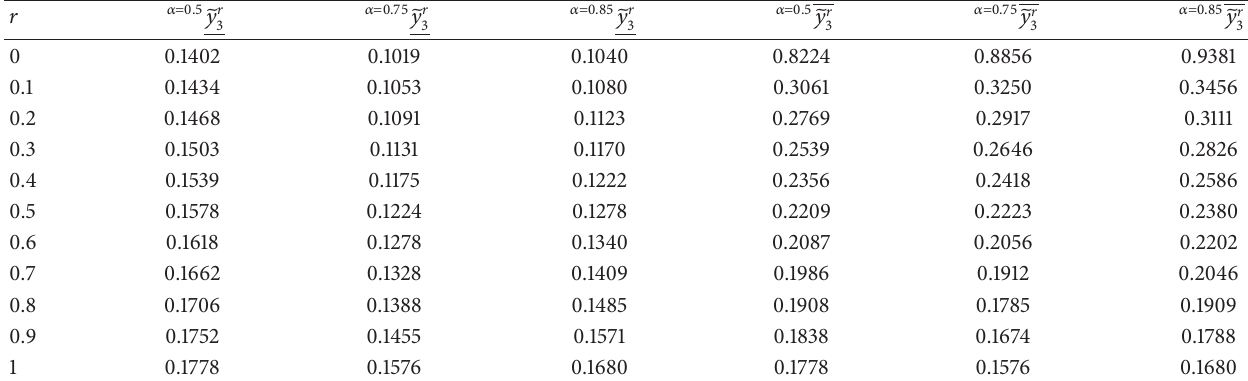
Table 7: The approximate solution of the proposed method for Example 64 at 𝑥 = 1 with 𝑚 = 3